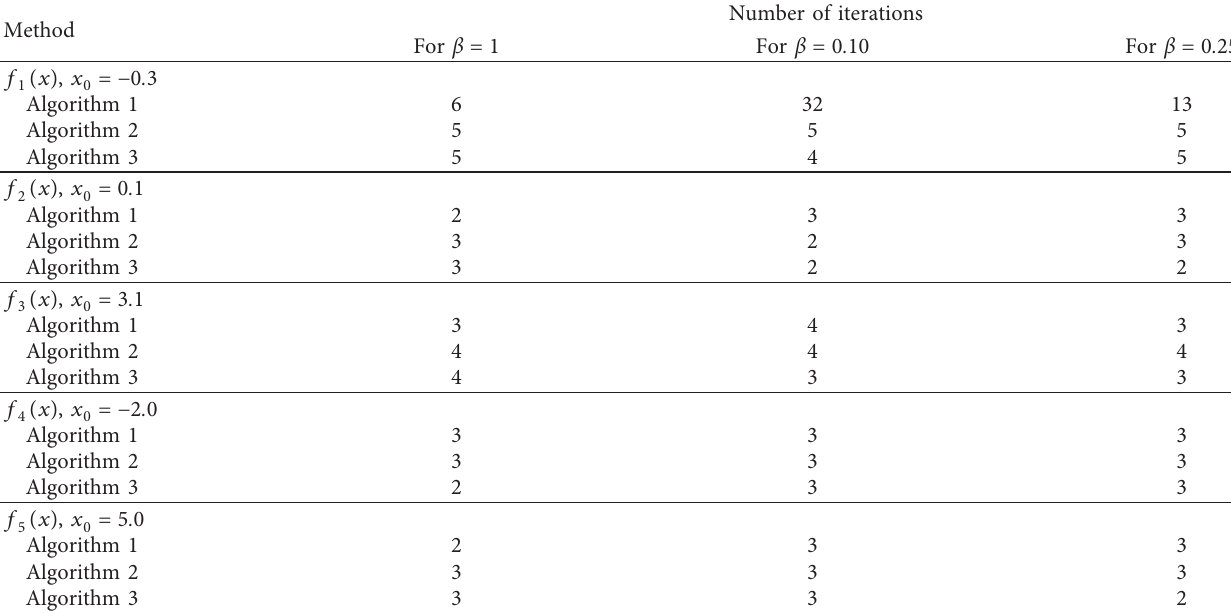
Table 3: The effect of parameter β on the proposed